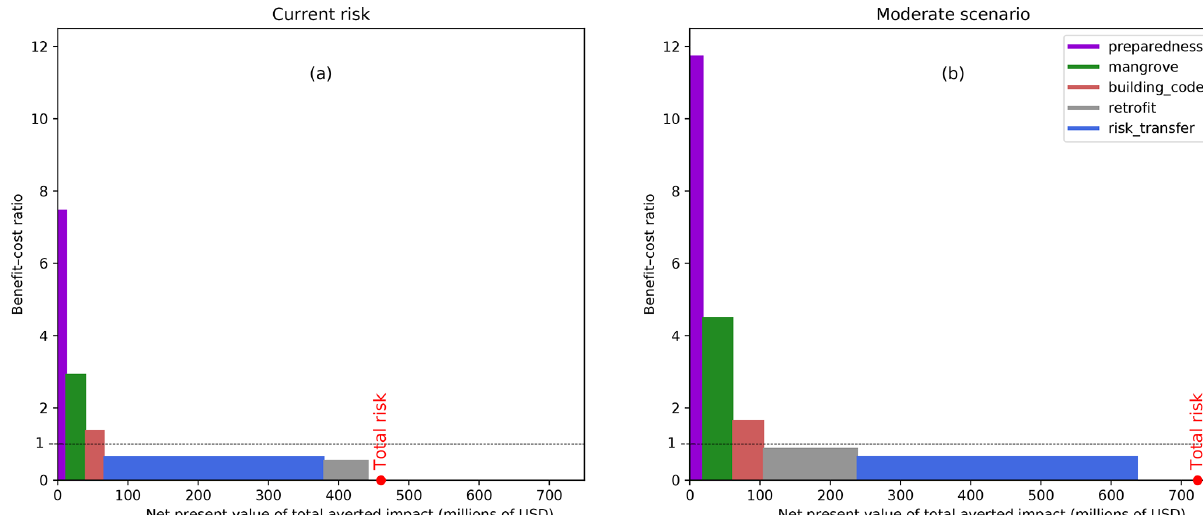
Figure 4. Net present value (NPV) of each measures’ total benefit and benefit–cost ratio without a changing future (a) and with a scenario of moderate change (b) . “Total risk” indicates the NPV of the total damage expected if no measure is implemented (as in Fig. 3, above).